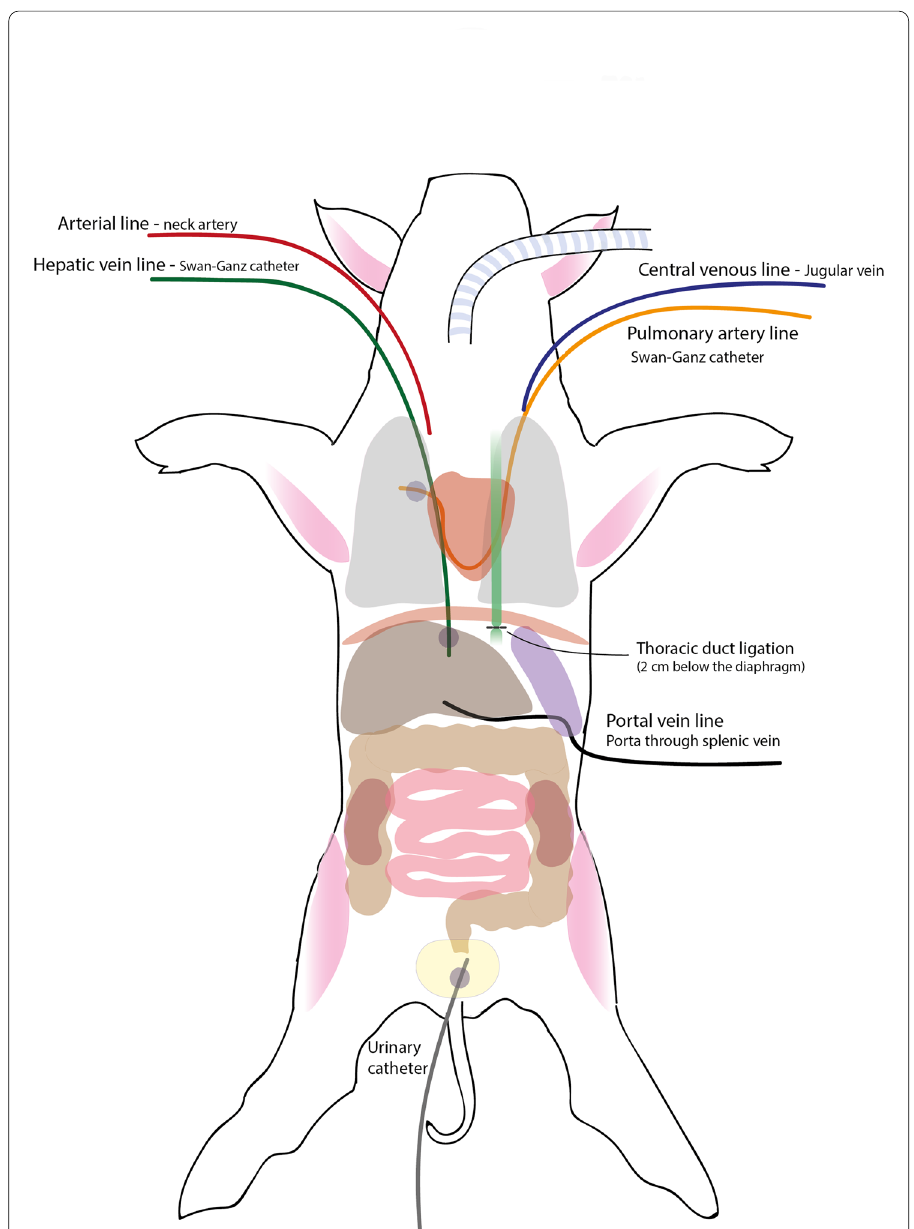
Fig. 1 Preparation setting. Five vascular catheters are represented in the image: an arterial line, a central venous line, a hepatic vein line, a portal vein line and a pulmonary artery line. From four of the lines (excluding central venous line) blood samples were taken at baseline and hourly during the observation for blood gas analysis and cytokines concentration assessment. In the image the thoracic duct is represented in green and the level of ligation of the Edema group is reported. The abdominal organs analyzed in the study are all represented in the figure (lungs, small intestine, colon, liver, spleen and